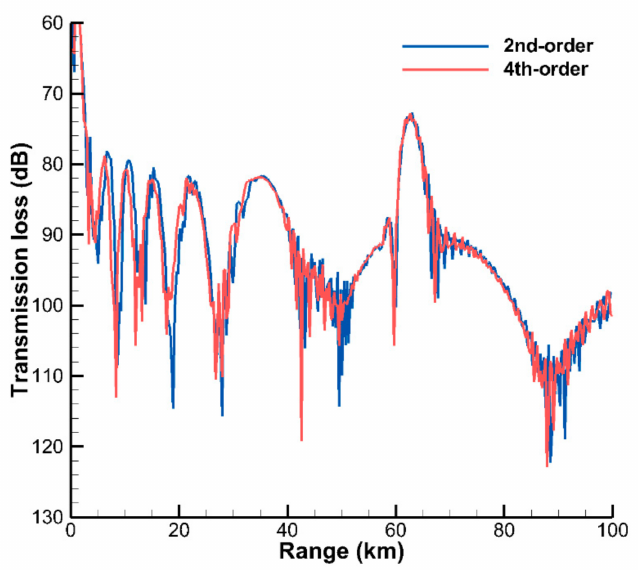
Figure 12. TL curves along z = 100 m for the Munk waveguide ( ρ w = 1.0 g/cm 3